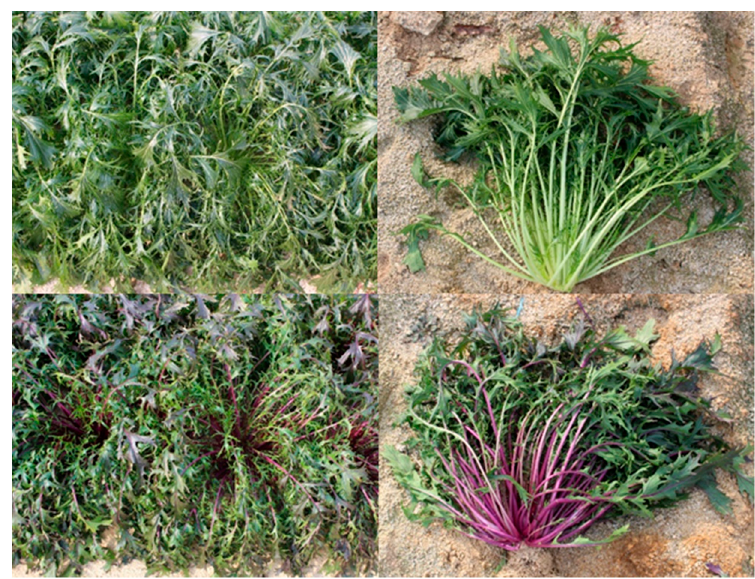
Figure 1. Phenotypes of the green and red cultivars of mizuna.